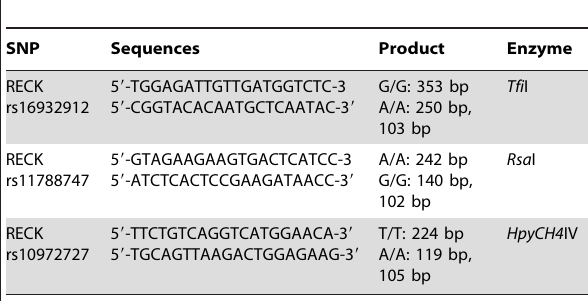
Table 1. Primer sequences and PCR-RFLP conditions for amplification of RECK